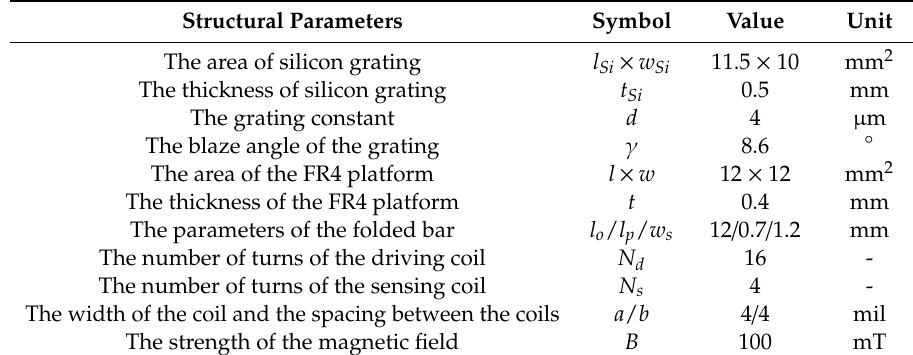
Table 1. Major structural parameters of the flame retardant 4 (FR4)-based electromagnetic scanning